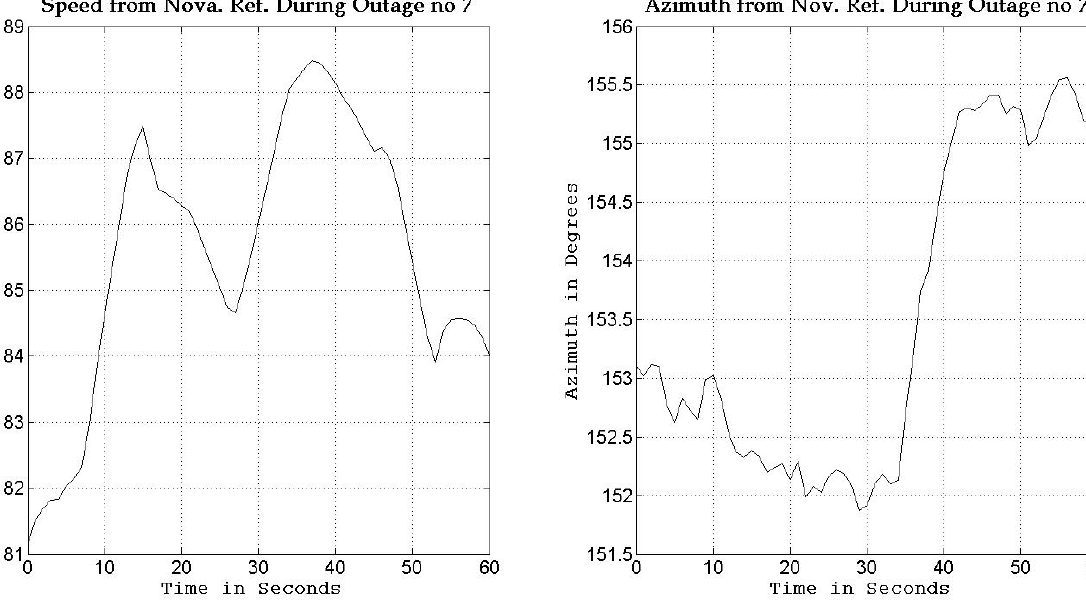
Figure 10. Forward speed and azimuth from Novatel reference during GPS outage #7 of the first